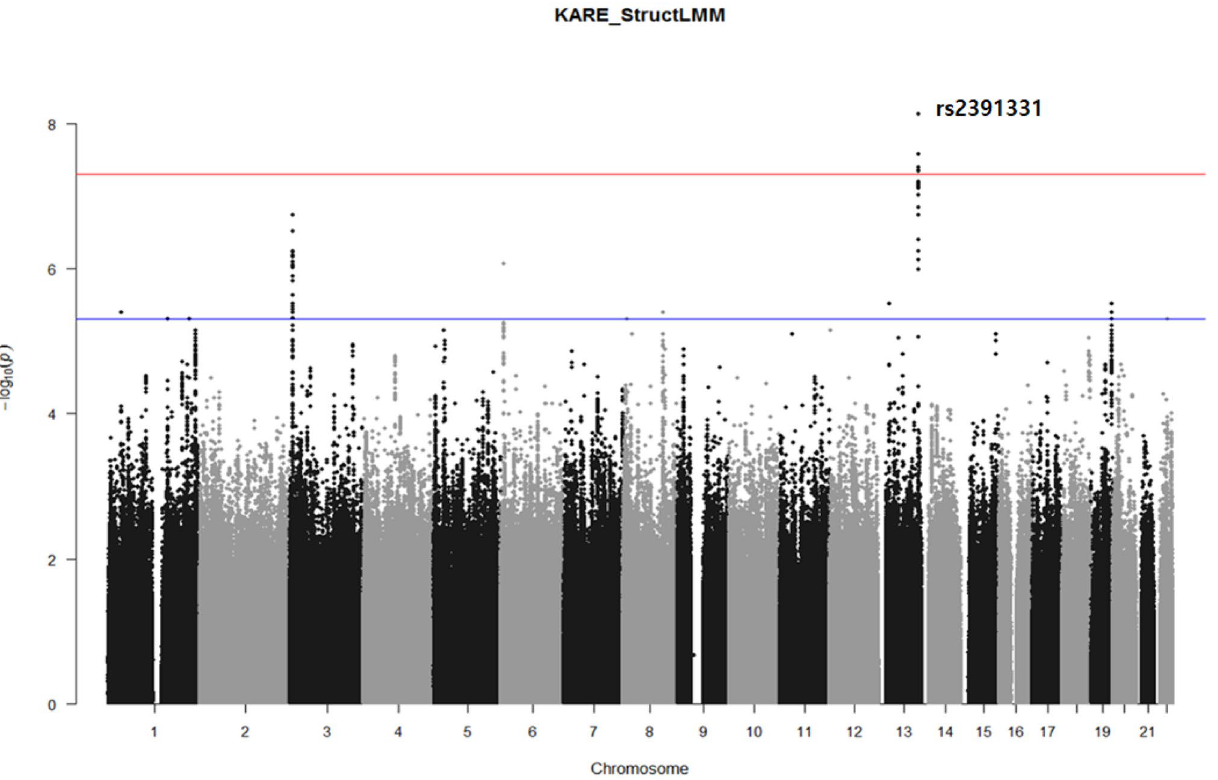
Figure 4. Manhattan plots for genome-wide interaction study using 7 environmental factors. The red line indicates the suggestive threshold ( P value < 5.00 × 10 −6 ). The blue line indicates the genome-wide significance threshold ( P value < 5.00 × 10 −8 ).